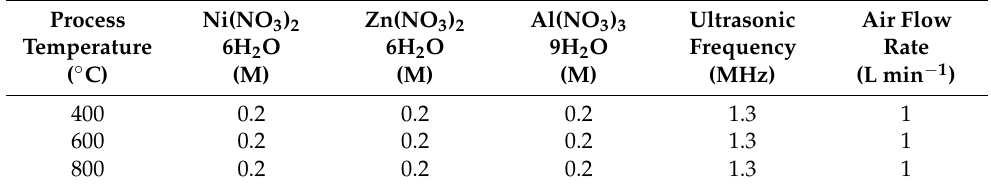
Table 1. Experimental